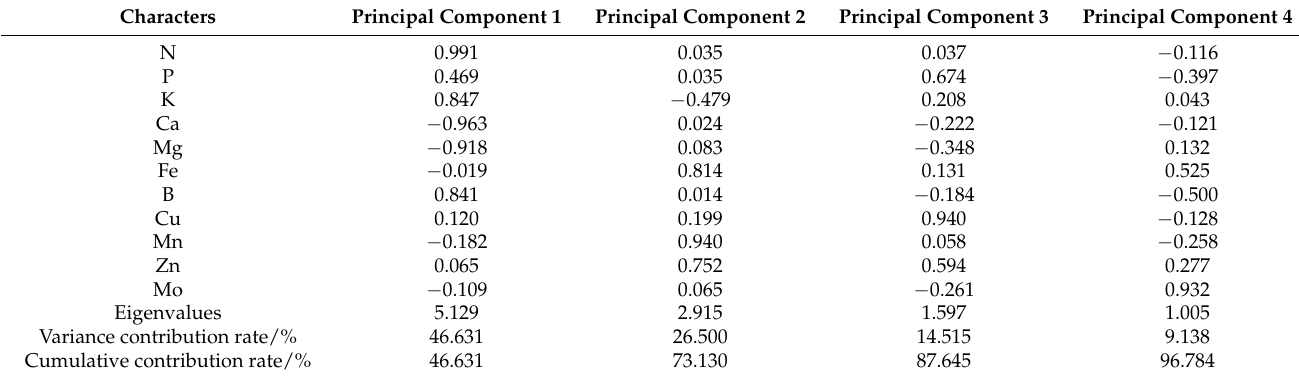
Table 4. Analysis of nutrient factors in healthy